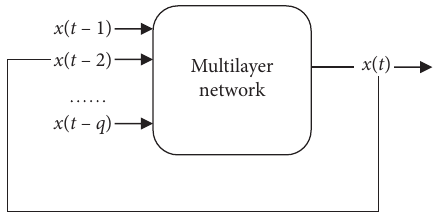
Figure 1: Nonlinear autoregressive neural